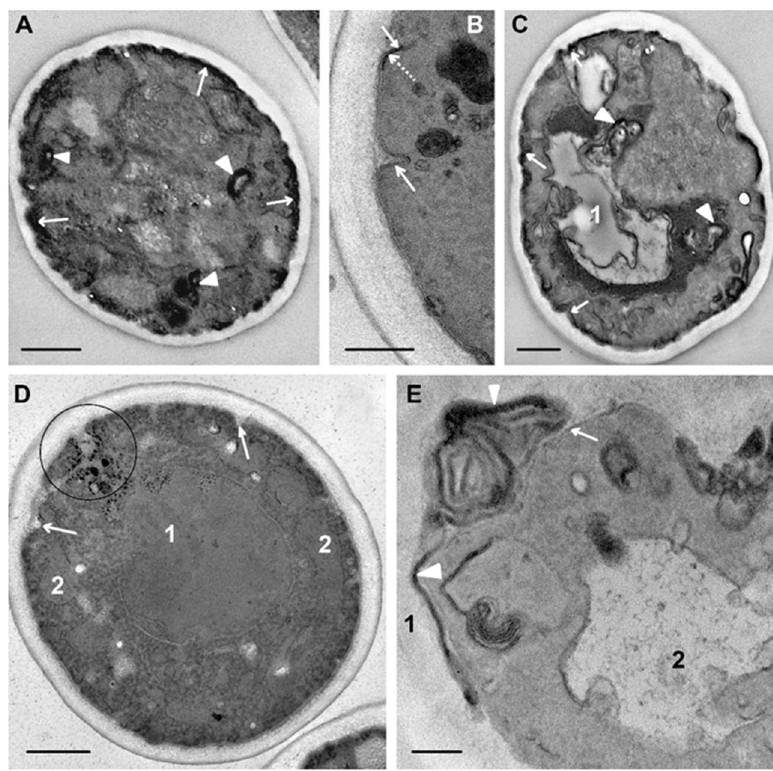
Figure 9. Changes in ultrastructure of C. albicans incubated for 75 min with R9F2 peptide. ( A ) a cell with destroyed organoids, arrows show osmiophilic material on the cell surface; arrowheads show osmiophilic multimembrane structures in the cytoplasm. ( B ) plasma membrane invaginations (shown with arrows) at higher magnification; dotted arrows are pointed at osmiophilic areas. ( C ) a cell with an electron-transparent vacuole ( 1 ) and destroyed organoids; the arrows show osmiophilic material on the cell surface; arrowheads show osmiophilic multimembrane structures in the cytoplasm. ( D ) slightly changed cell: 1 –nucleus; 2 –mitochondria; arrows show plasma membrane invaginations; oval shows deep branched invagination. ( E ) a part of a damaged cell. Arrow shows plasma membrane; arrowheads show osmiophilic membrane structures on the cell surface; 1–cell wall; 2–vacuole. ( E ) unstained section. Scale bars correspond to 1 mkm ( A , C , D ) and 200 nm ( B , E